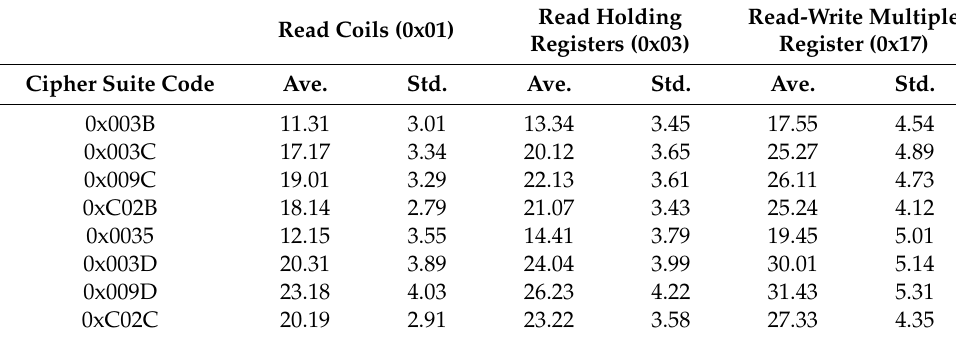
Table 8. Average latencies (ms) and standard deviation for each of the cipher suites when applying the RBAC model. Read Holding Read-Write Multiple Read Coils (0x01) Registers (0x03) Register (0x17) Cipher Suite Code Ave. Std. Ave. Std. Ave.